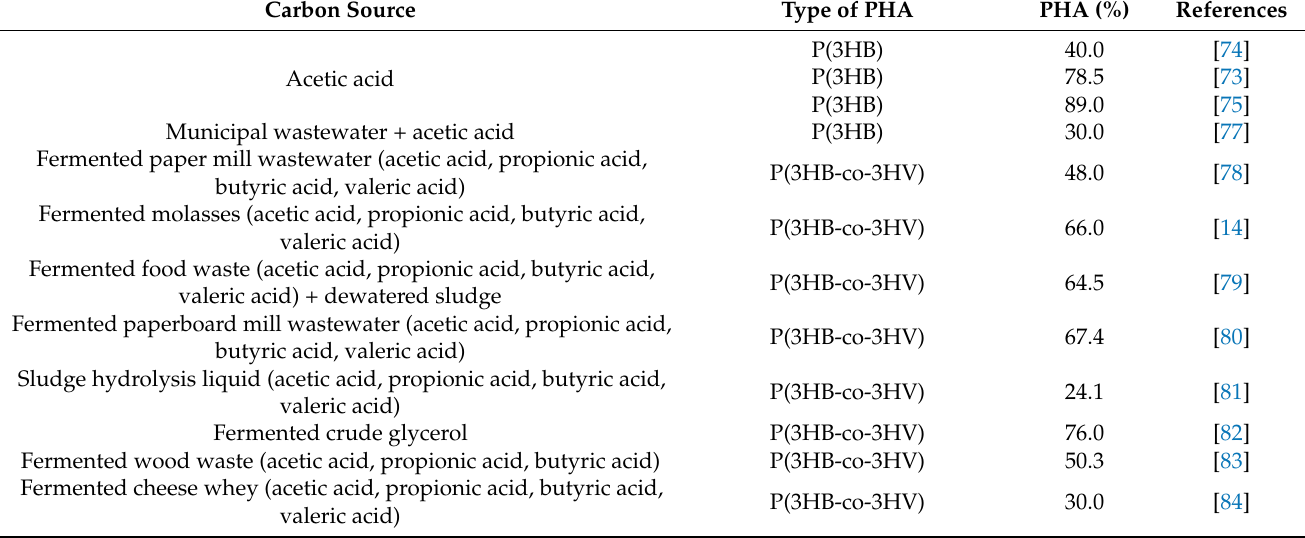
Table 4. Production of PHAs by mixed microbial cultures using volatile fatty